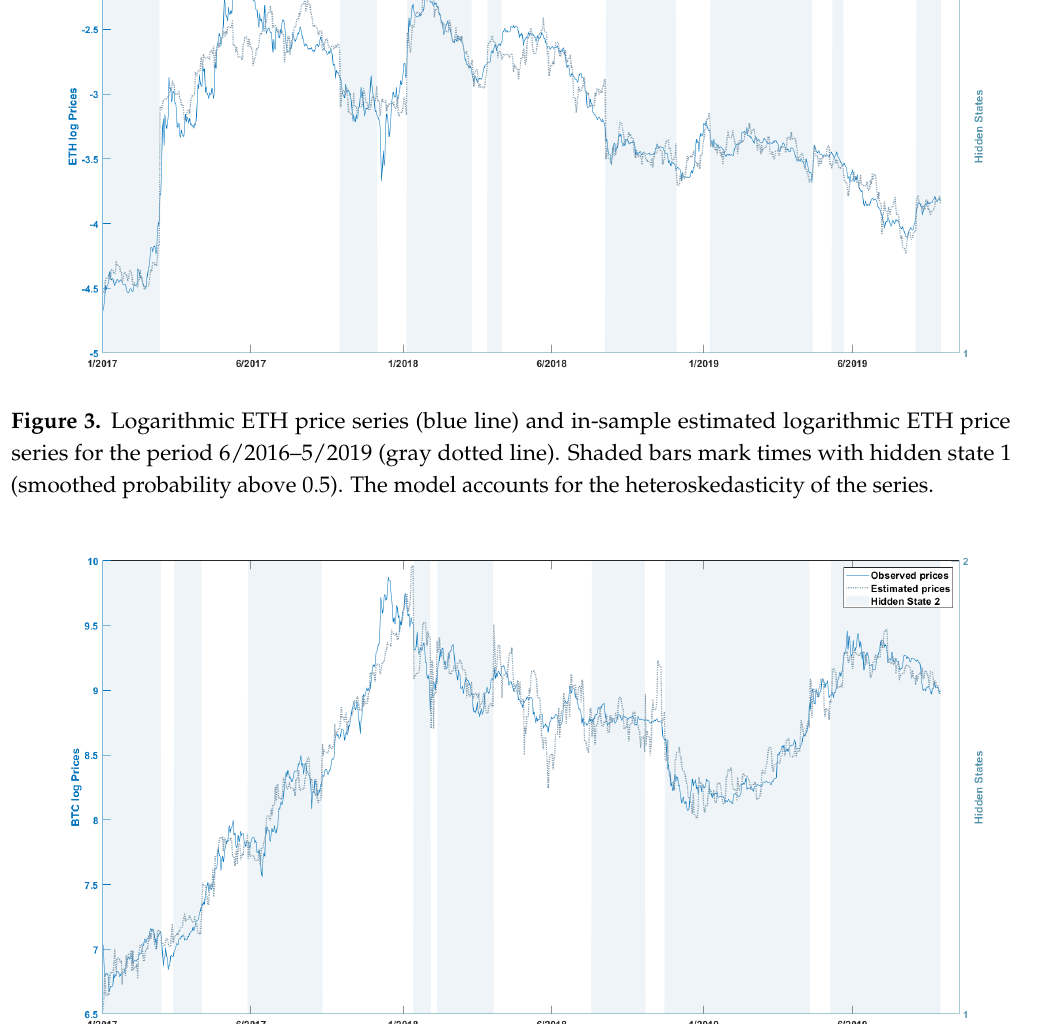
Figure 4. Logarithmic BTC prices series (blue line) and in-sample estimated logarithmic BTC price series for the period 6/2016–5/2019 (gray dotted line). Shaded bars mark times with hidden state 1 (smoothed probability above